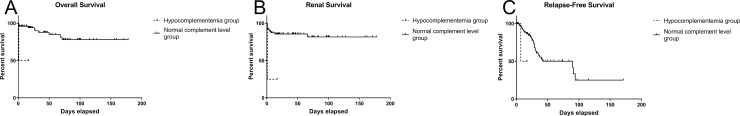
Kaplan-Meier estimate of overall (A), renal (B) and relapse-free (C) survival rates in patients with granulomatosis with polyangiitis or microscopic polyangiitis, according to low or normal plasma complement levels (absolute values) performed before treatment (p = 0.0011, <0.001 and 0.093, respectively).